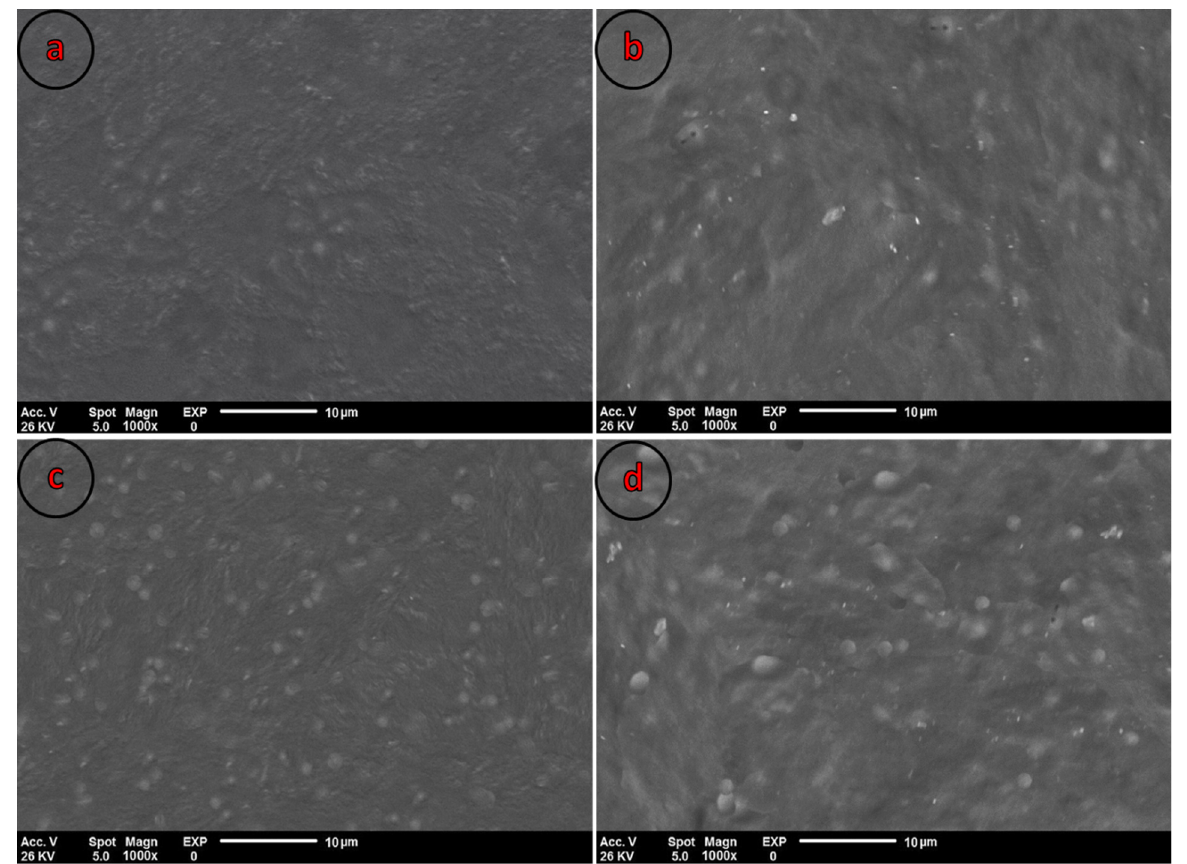
Figure 2. SEM micrographs of the control film ( a ), control film containing 1% CEO ( b ), control film containing 2% CEO ( c ), and control film containing 3% CEO ( d ).